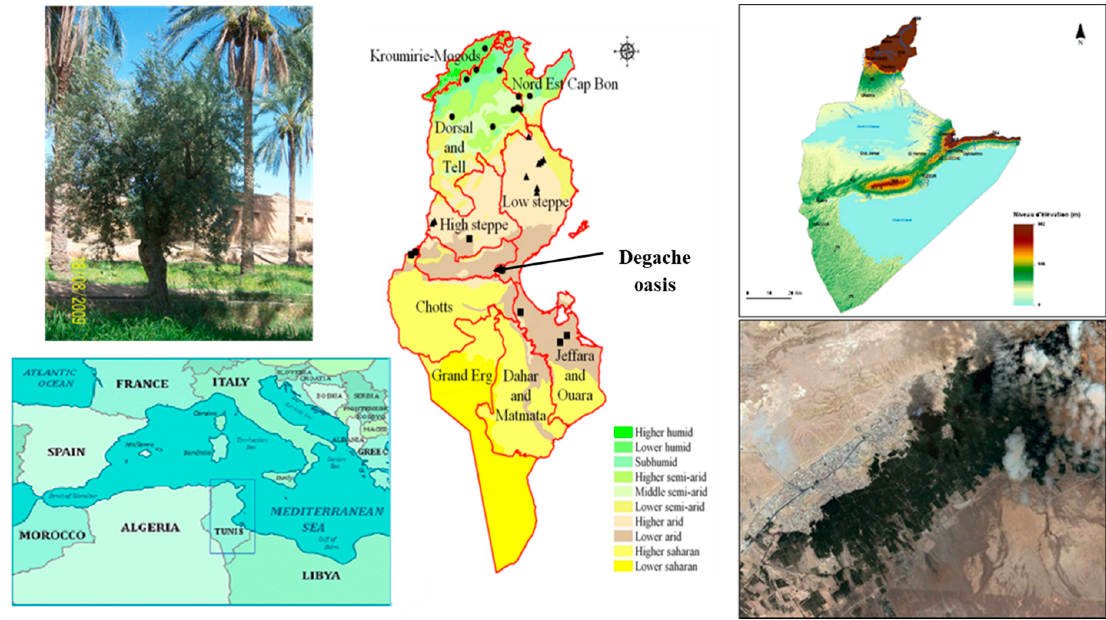
Figure 1. Geographical localization of the Degache oasis from where the 47 olive samples were collected: map of the Mediterranean Basin, Agro-ecological map of Tunisia (redrawn from CNEA, 2007) and the geographical borders of Tozeur governorate where Degache oasis is located. Table 1. Genetic diversity indices number of alleles ( Na ), effective number of alleles ( Ne ), Shannon’s diversity index ( I) , observed heterozygosity ( Ho ), expected heterozygosity ( He ), fixation index (F), and PIC values revealed in the 37 olive Degache accessions analyzed with 10 SSR markers.